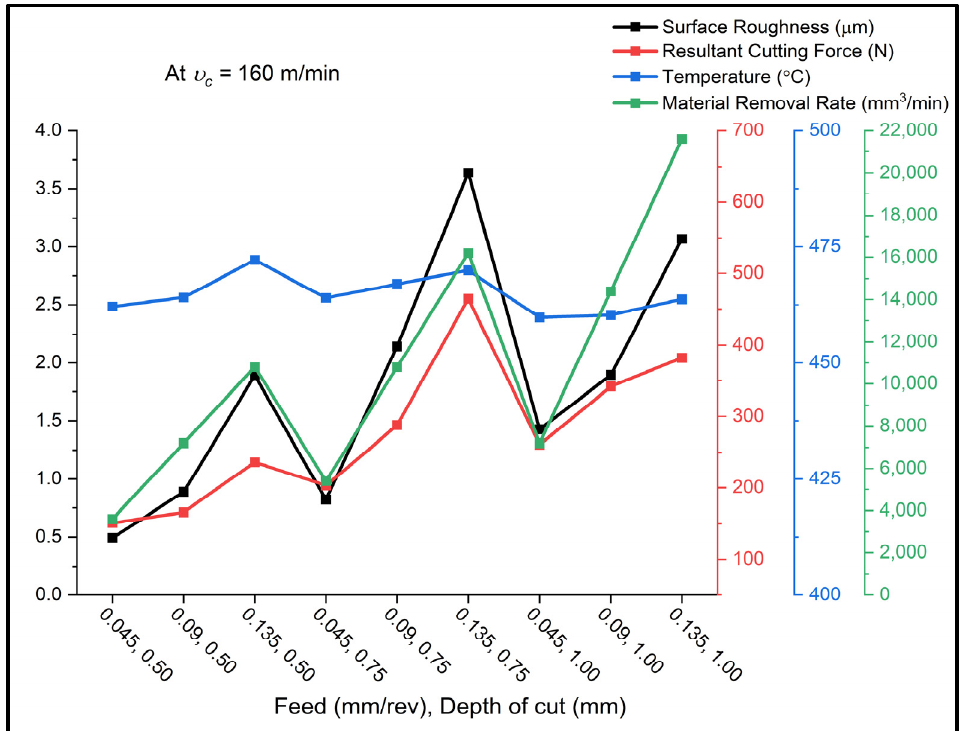
Figure 12. The experimental results at cutting speed = 160 m/min.